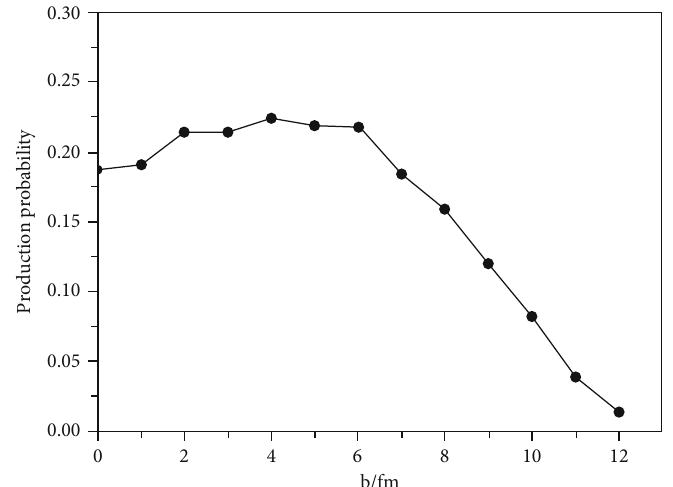
Figure 1: The dependence of the production probability on the impact parameter about the new ternary fi ssion of 197 Au+ 197 Au system at an energy of 15MeV/nucleon.